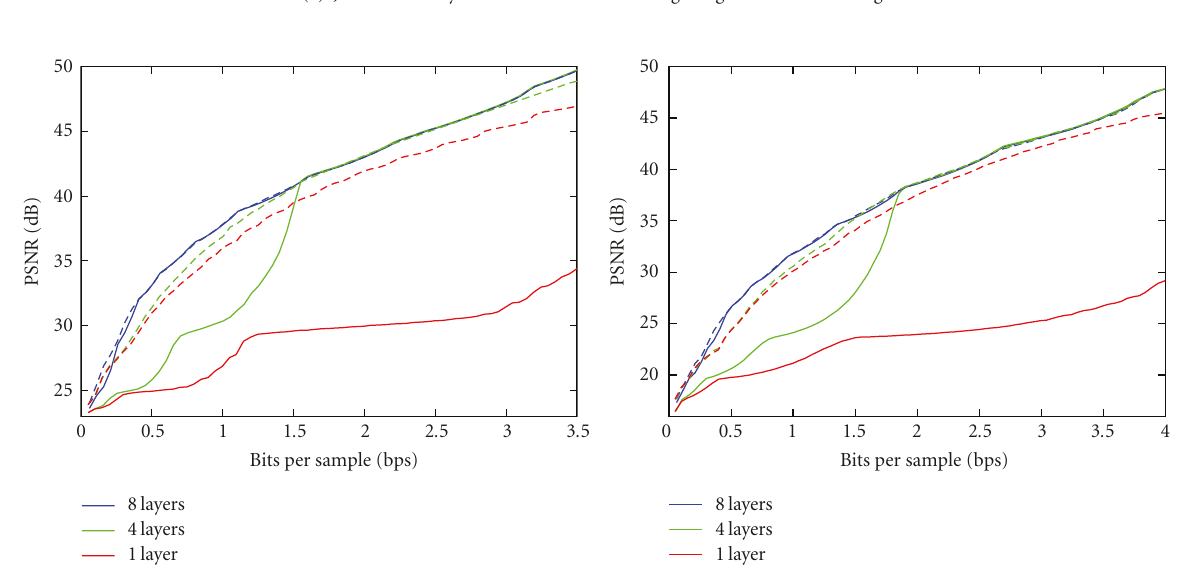
Figure 4: Performance evaluation of BWLT in a transcoding application (dashed plot), compared to the common approach of layer truncation (solid